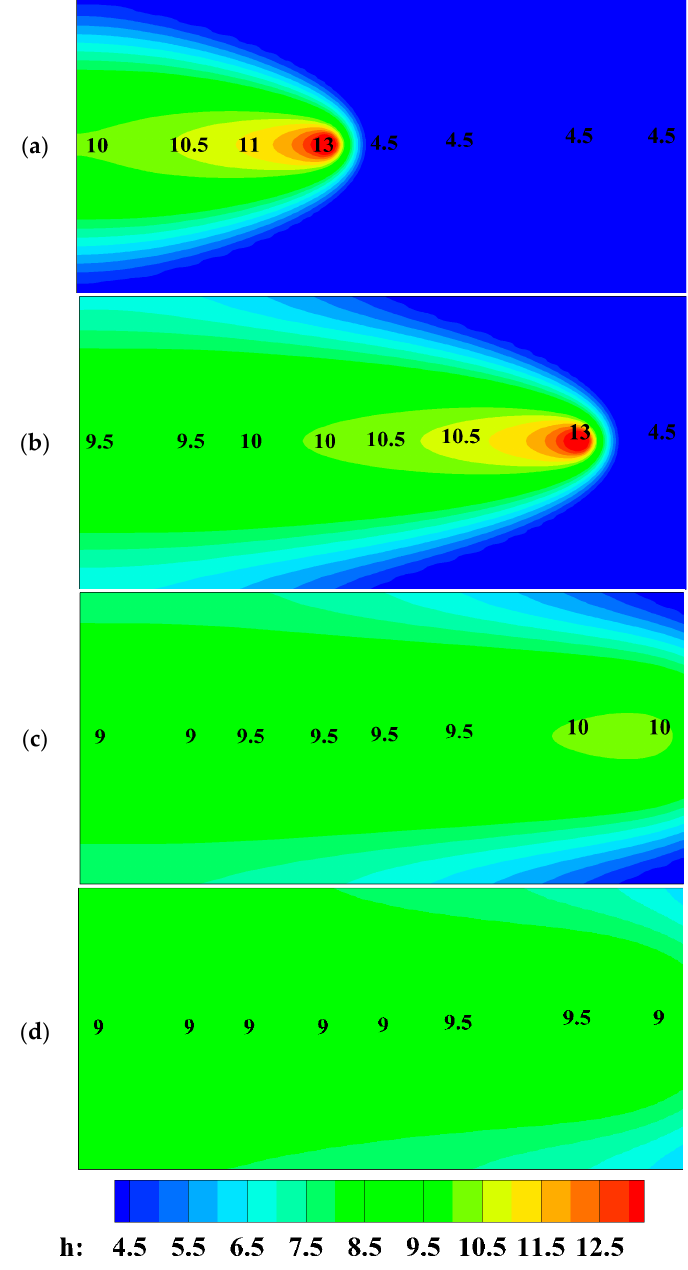
Figure 14. Evolution of the heat transfer coefficient, h (W/m 2 K), at instants ( a ) 9.5 s, ( b ) 19 s, ( c ) 28.5 s, and ( d ) 38.0 s for the GTA stainless steel welding.